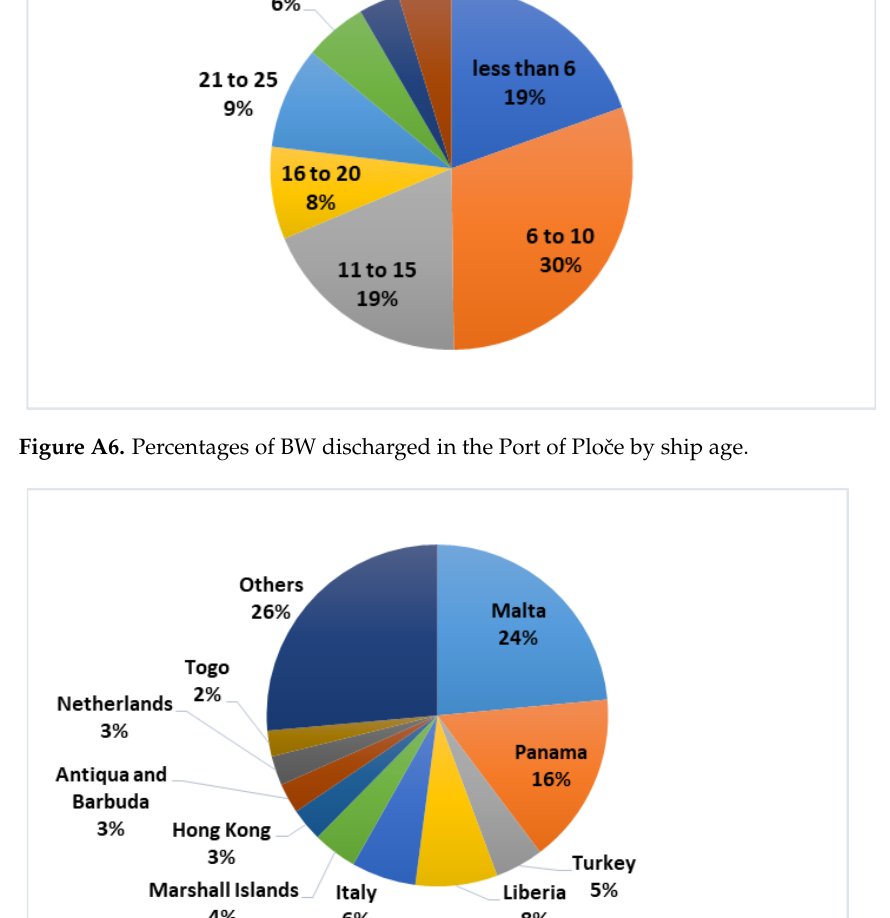
Figure A7. Percentage of BW discharged in the Port of Ploče by ship flag.